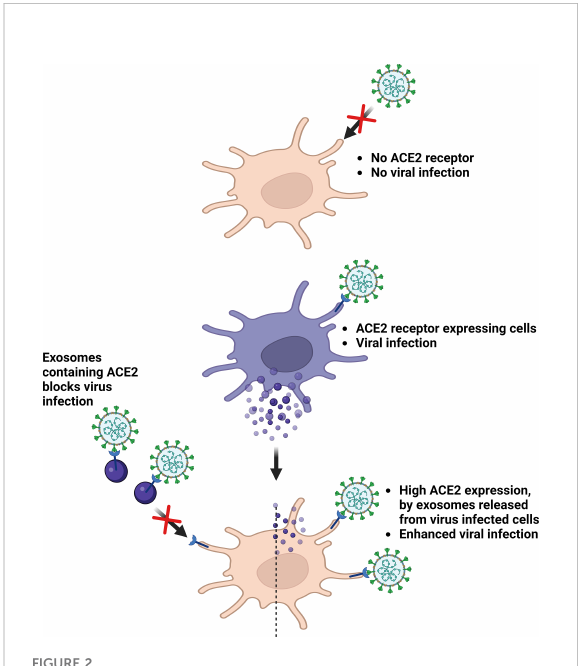
FIGURE 2 Roles of exosomes in virus infection. ACE2, Angiotensin converting enzyme 2. Created with